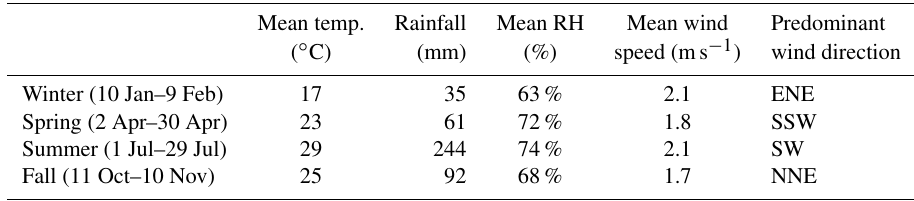
Table 2. General meteorological conditions during the observation period in the PRD. Mean temp.